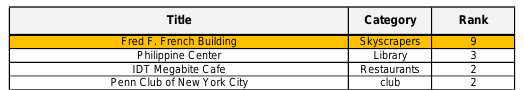
Table 6. 4 Wikipedia entries (landmarks) with ranking scores for point P5 after the initial